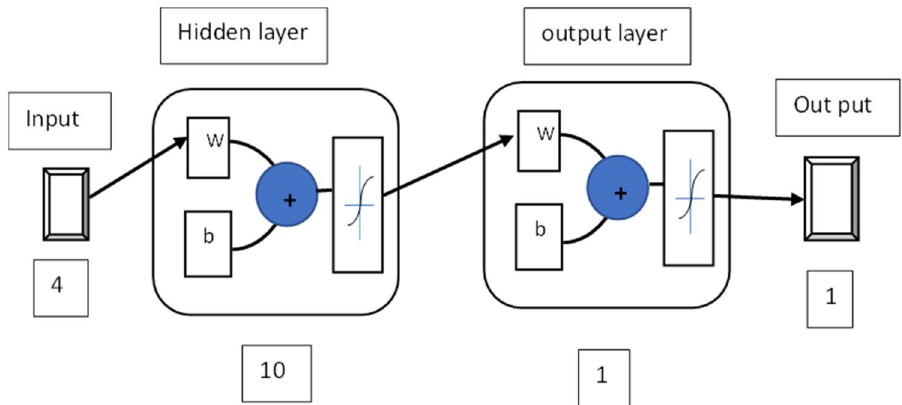
Fig. 3 Typical architecture of ANN